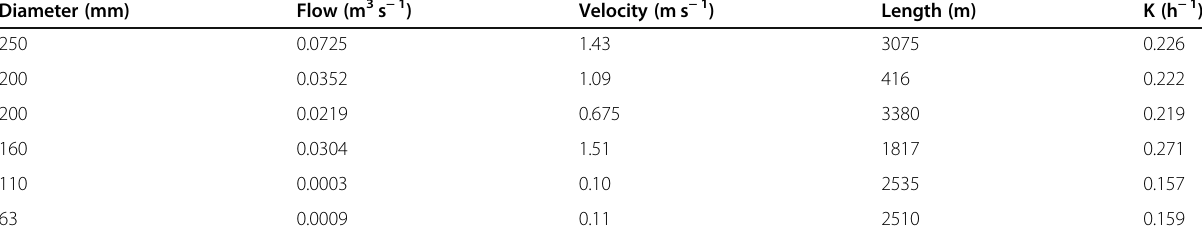
Table 3 Experimental results obtained when determining the total decay coefficient K Diameter (mm)